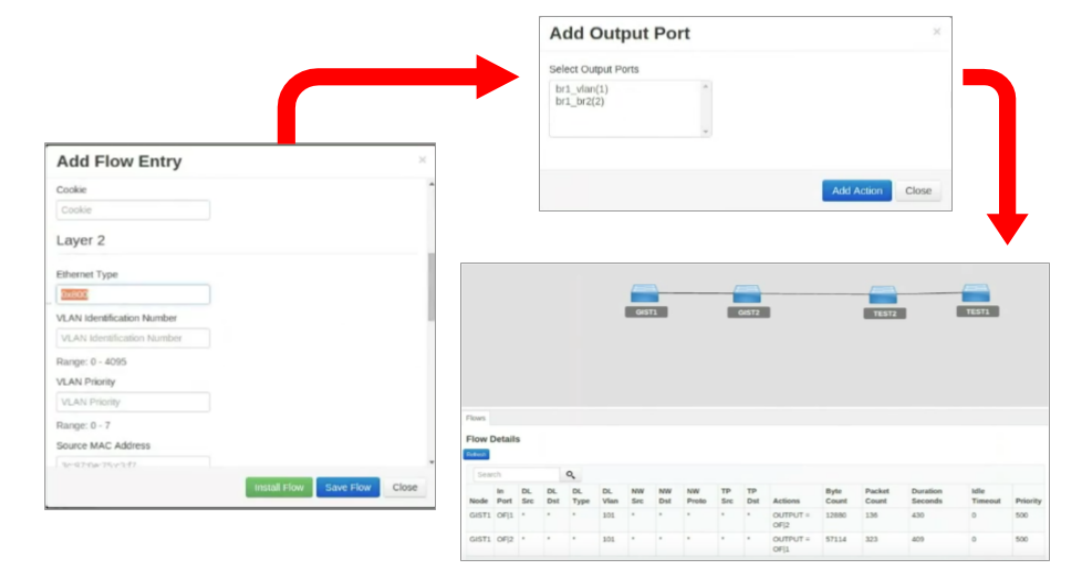
Figure 14. OpenStack VMs Preparation and Configuration.